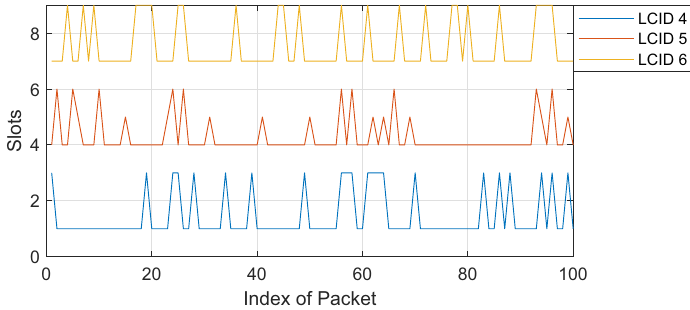
Figure 8. Arrival slots of TSN traffic classes with dynamic